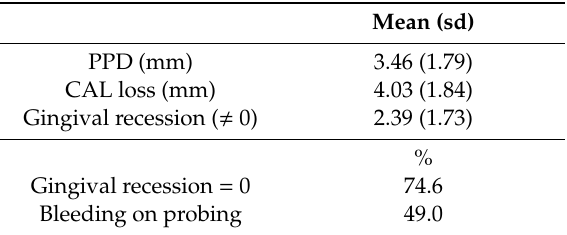
Table 1. Clinical characteristics of patients (total